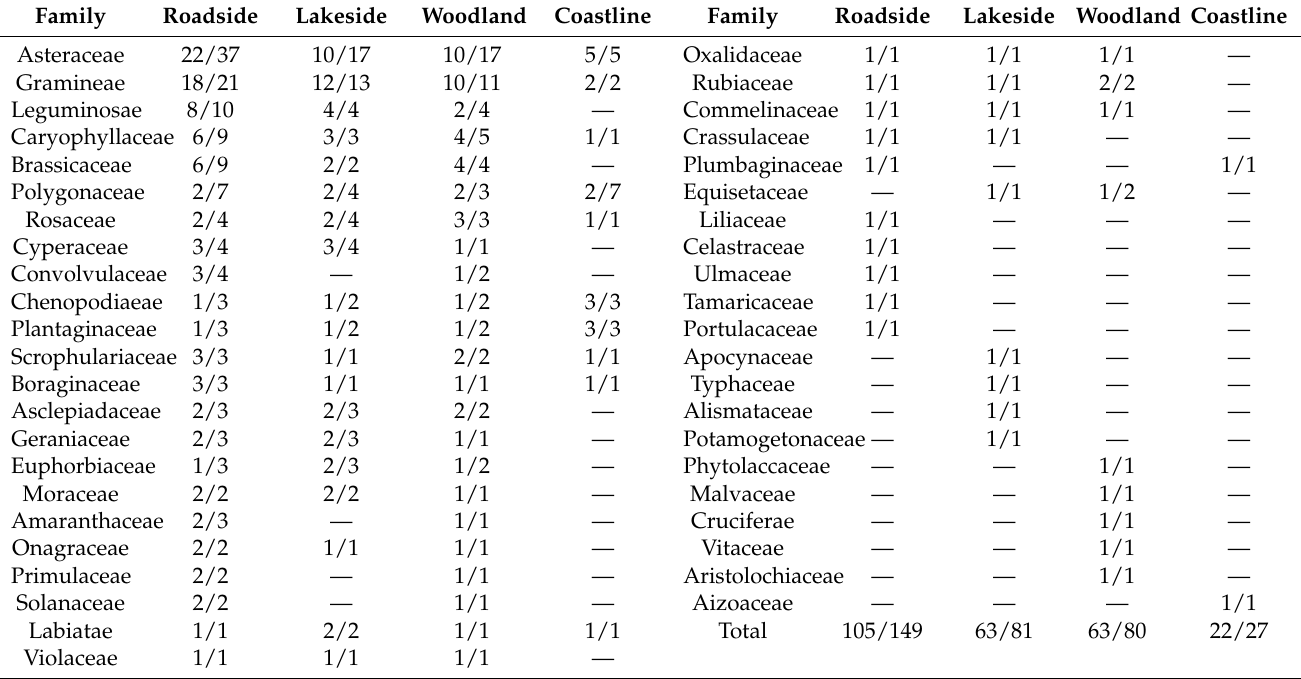
Table 2. The family and numbers of genera and species in different